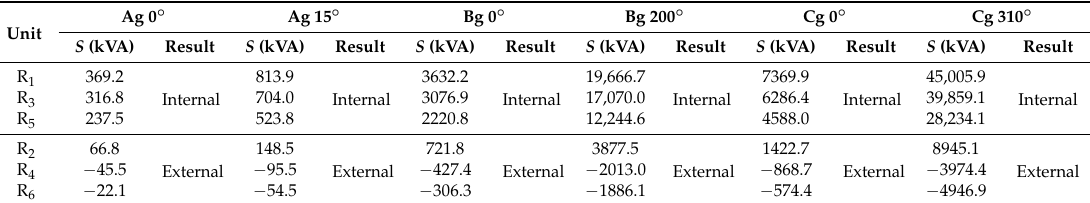
Table 3. Simulation results of the different fault inception angles for the busbar I faults.